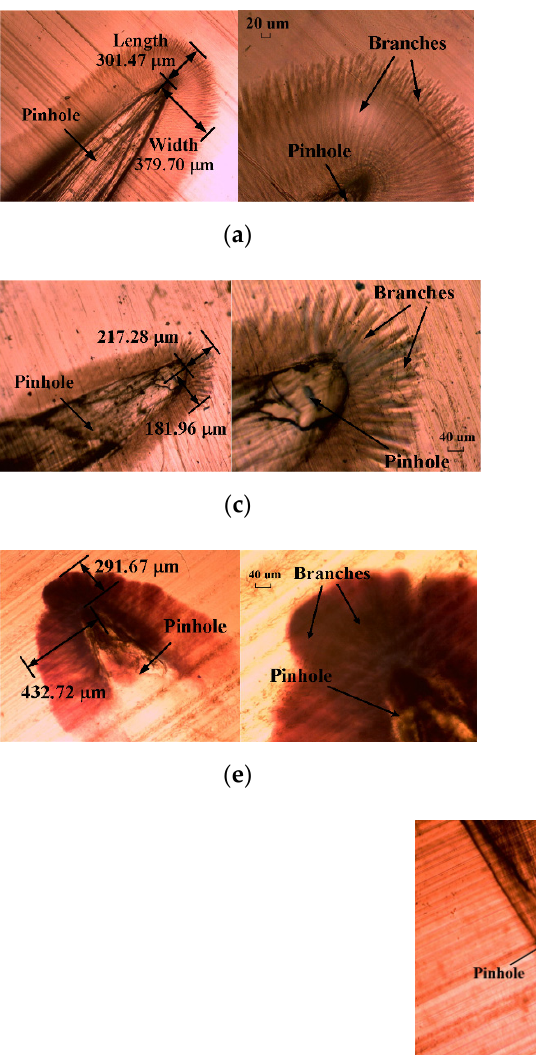
Figure 5. Maximum water tree length at different temperatures.